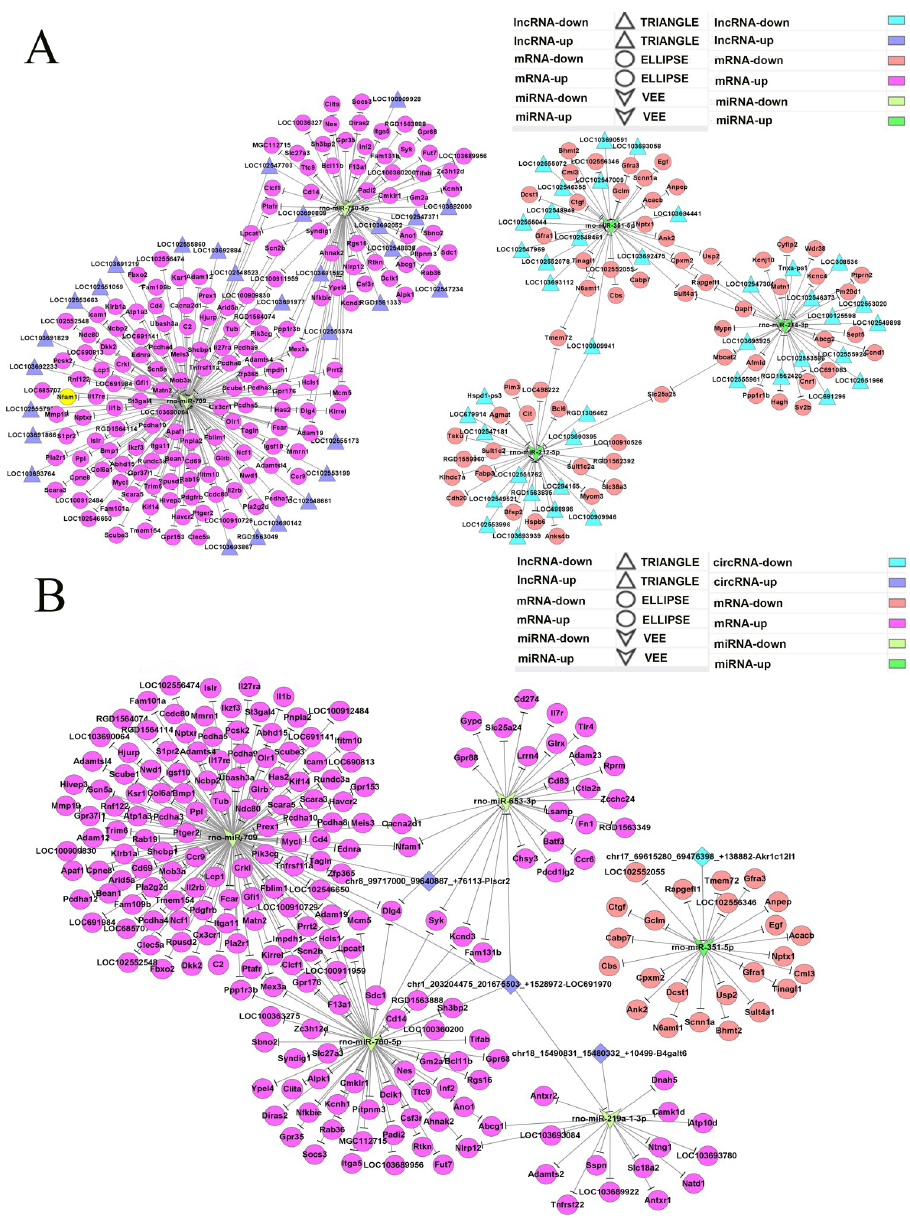
Fig 7. The competing endogenous RNA network for the 5 miRNAs with maximum interactions. (A) lncRNA- miRNA-mRNA competing endogenous RNA network. Multiple colours represent upregulation and downregulation of miRNAs, lncRNAs and mRNAs in the case sample compared with the control. Vee, triangle, and ellipse indicate DE-miRNAs, lncRNAs and mRNAs, respectively. (B) The circRNA-miRNA-mRNA competing endogenous RNA network. Multiple colours represent upregulation and downregulation of miRNAs, circRNAs and mRNAs in the case sample compared with the control. Vee, diamond, and ellipse indicate DE-miRNAs, circRNAs and mRNAs,